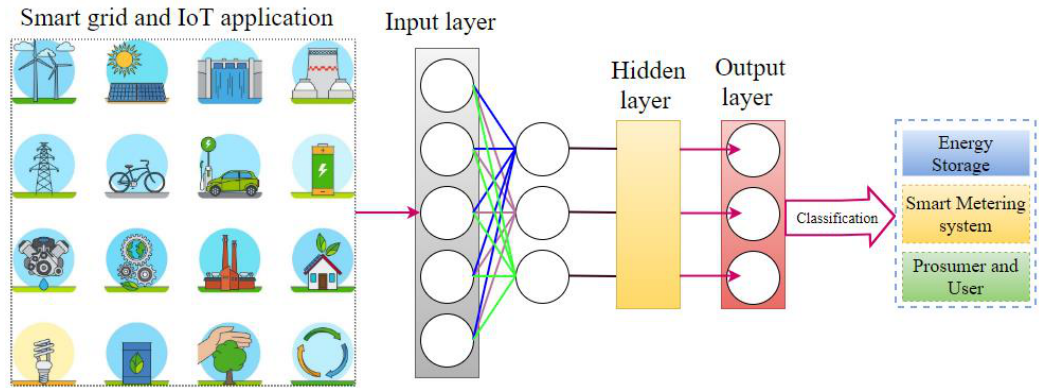
Figure 16. A schematic of applying deep learning for energy management applications in smart grids based on data from the internet of things (IoT) device (Adapted and retuned to smart grid context based on the artwork with permission from [134], 2020, IEEE).